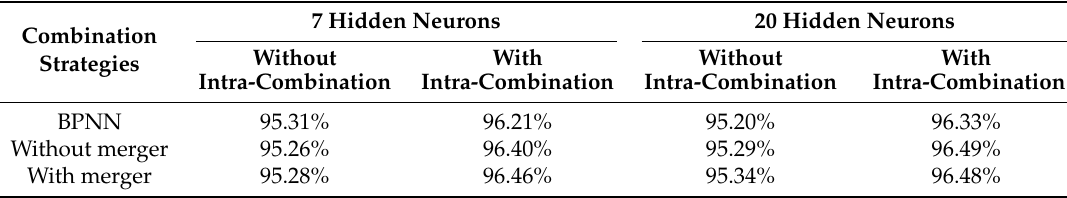
Table 4. Results of control experiments to verify the effectiveness of